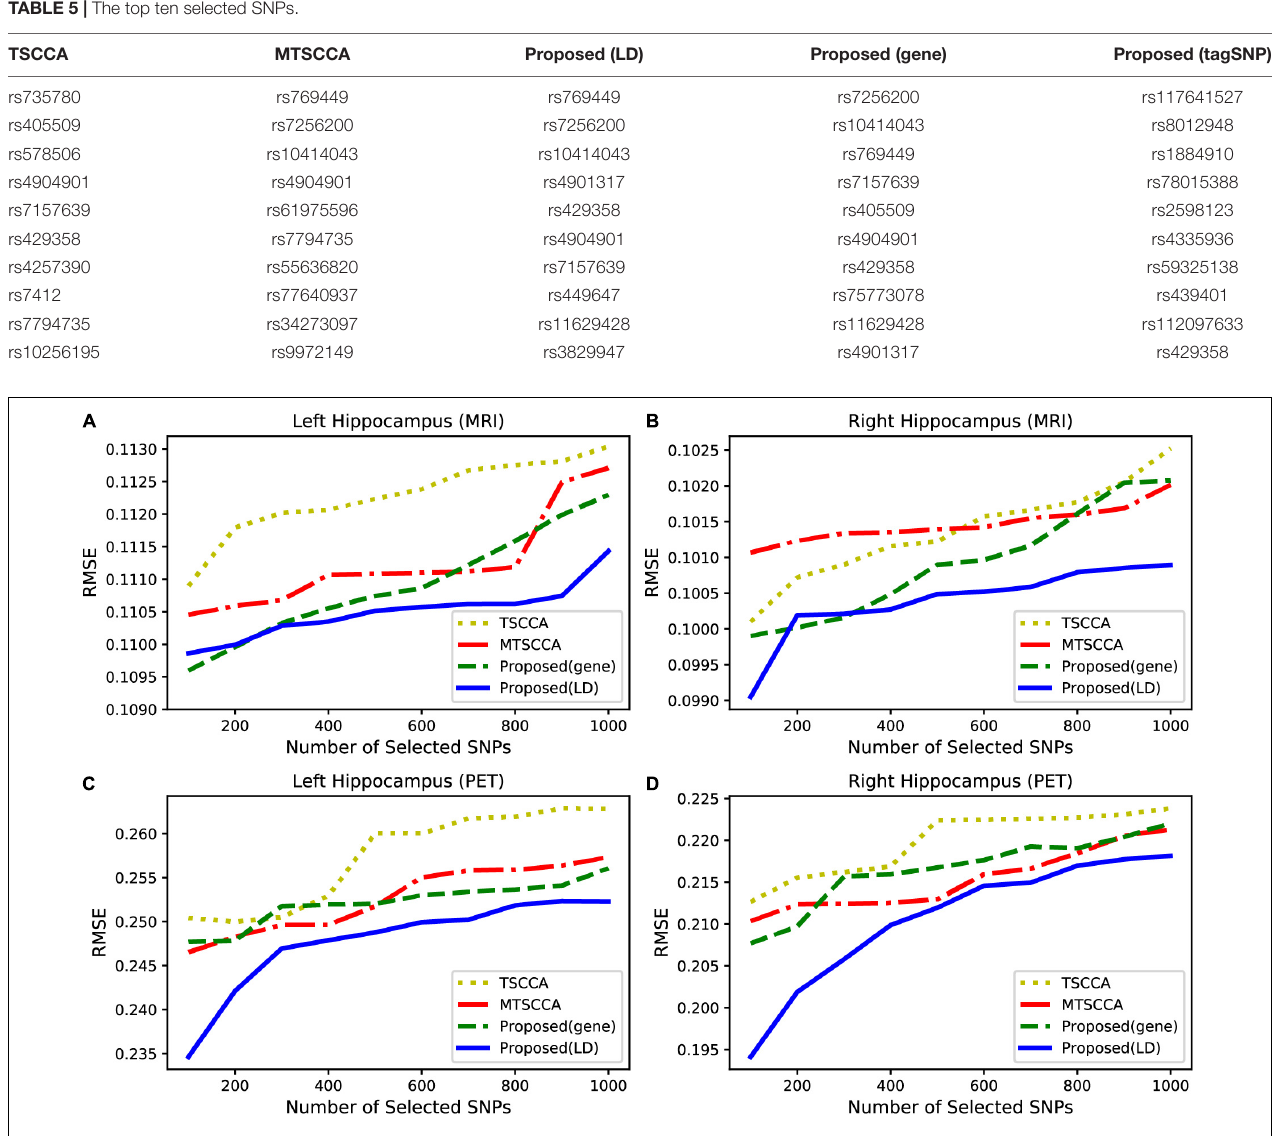
FIGURE 7 | Comparison of the RMSE with respect to different numbers of SNPs from 100 to 1000. (A) QT of left hippocampus based on MRI scan. (B) QT of right hippocampus based on MRI scan. (C) QT of left hippocampus based on PET scan. (D) QT of right hippocampus based on PET